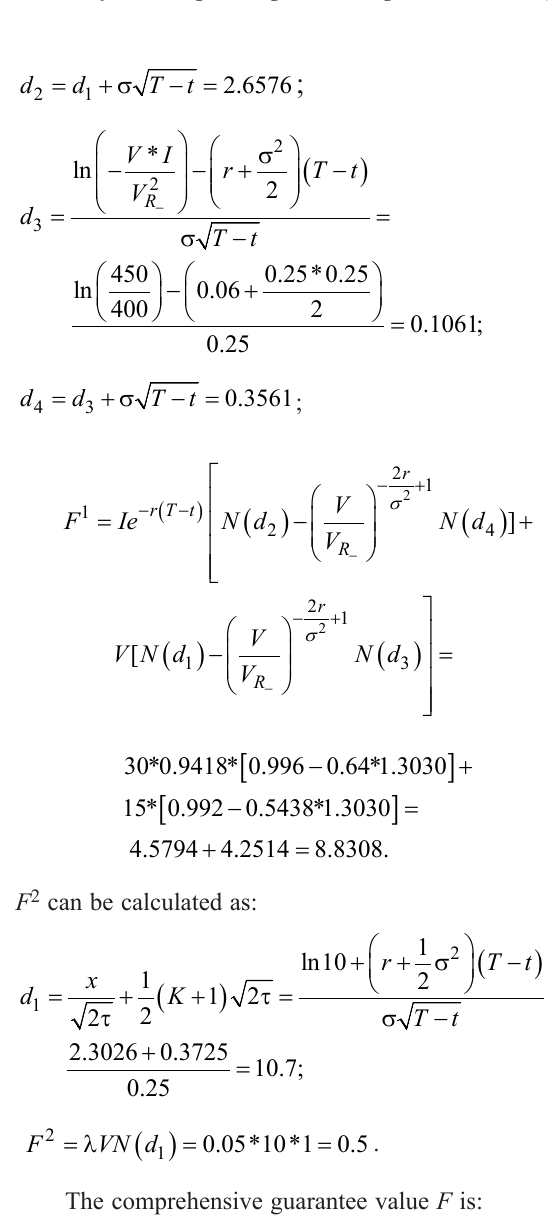
Table 1. The values of F Values of V